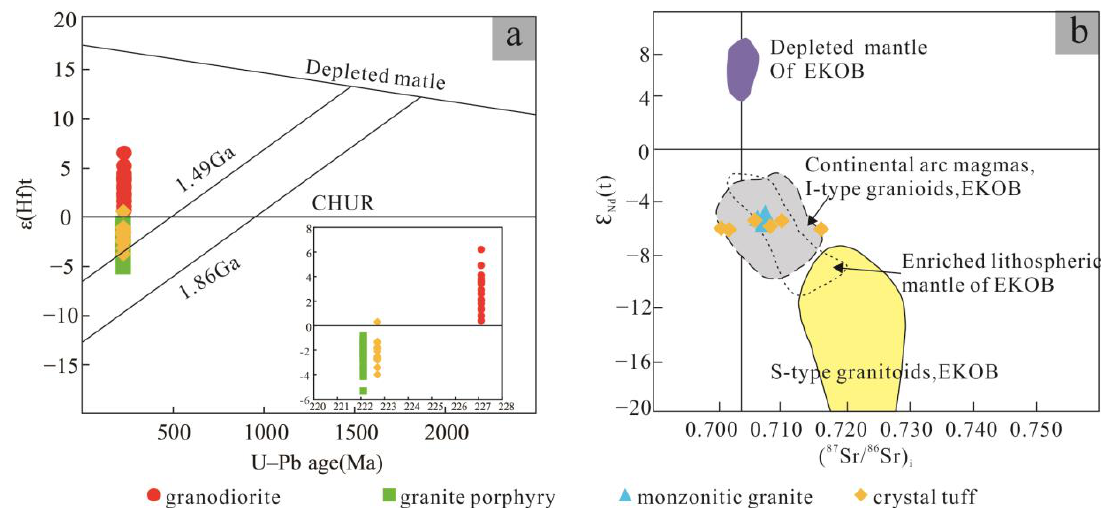
Figure 7. ( a ) εHf(t)–Age plot for zircons from granitic rocks and crystal tuff; ( b ) εNd(t)–( 87 Sr/ 86 Sr)t Figure 7. ( a ) ε Hf(t)–Age plot for zircons from granitic rocks and crystal tu ff ; ( b ) ε Nd(t)–( 87 Sr / 86 Sr)t diagram (after [55]) for monzonitic granite and crystal tuff of the Hutouya deposit. diagram (after [55]) for monzonitic granite and crystal tu ff of the Hutouya